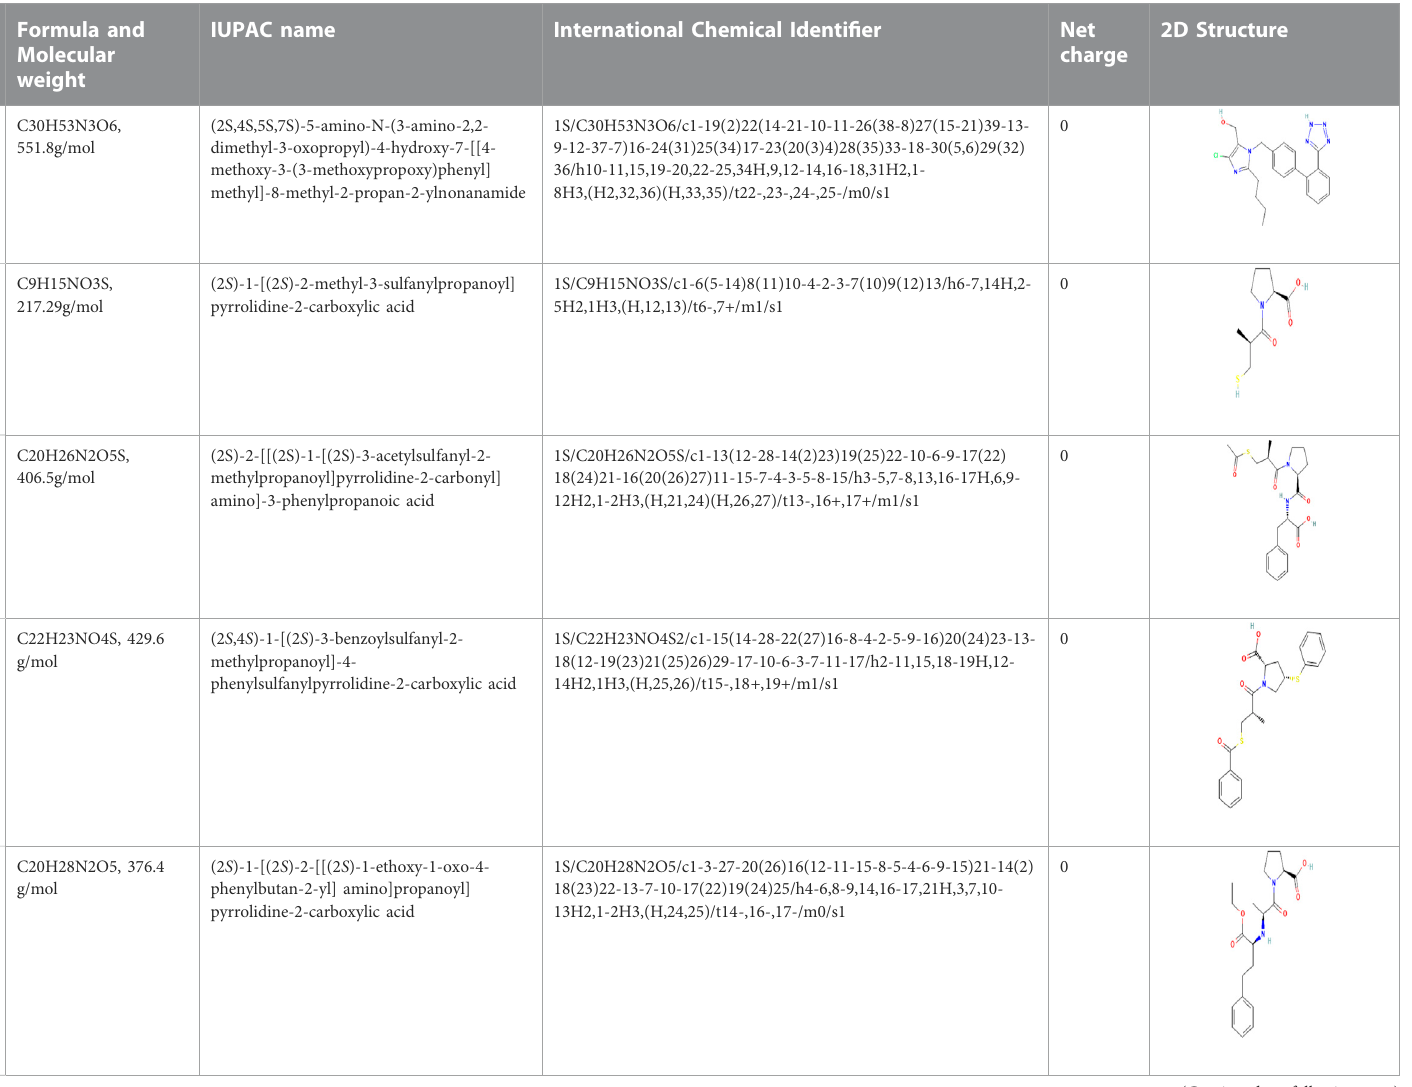
TABLE 2 Molecular structural details of RAAS inhibitors (Ref: